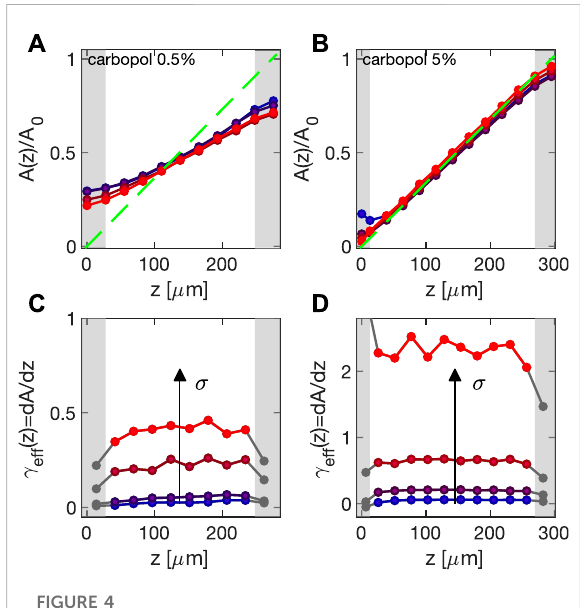
FIGURE 4 (A,B) Deformation pro fi le A ( z ) normalized by the macroscopic deformation amplitude A 0 as determined from the speckle correlation analysis. Data obtained for Carbopol 0.5% (A) and 5% (B) at ω = 2 π rad/s for stress amplitudes ranging from σ = 1.5 Pa (blue) to σ = 13 Pa (red) for Carbopol 0.5%, and from σ = 11 Pa (blue) to σ = 190 Pa (red) for Carbopol 5%. Green dashed line denotes the ideal strain pro fi le presumed in any macroscopic rheology experiment. Gray patches mark gap regions in which the amplitude estimation is biased by fi nite depth-of-focus. ( C,D) Correspondingeffectivelocalstrain γ eff ( z ),evaluatedusingrelation 8forCarbopol0.5% (C) and5% (D) .Graymarkscorrespondtothe z for which the estimation of the local strain is not